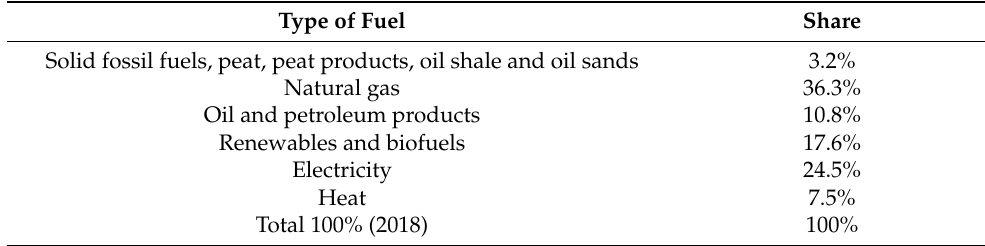
Table 2. Final energy consumption in the residential sector (household)—share of fuels EU-28 1 . Type of Fuel Share Solid fossil fuels, peat, peat products, oil shale and oil